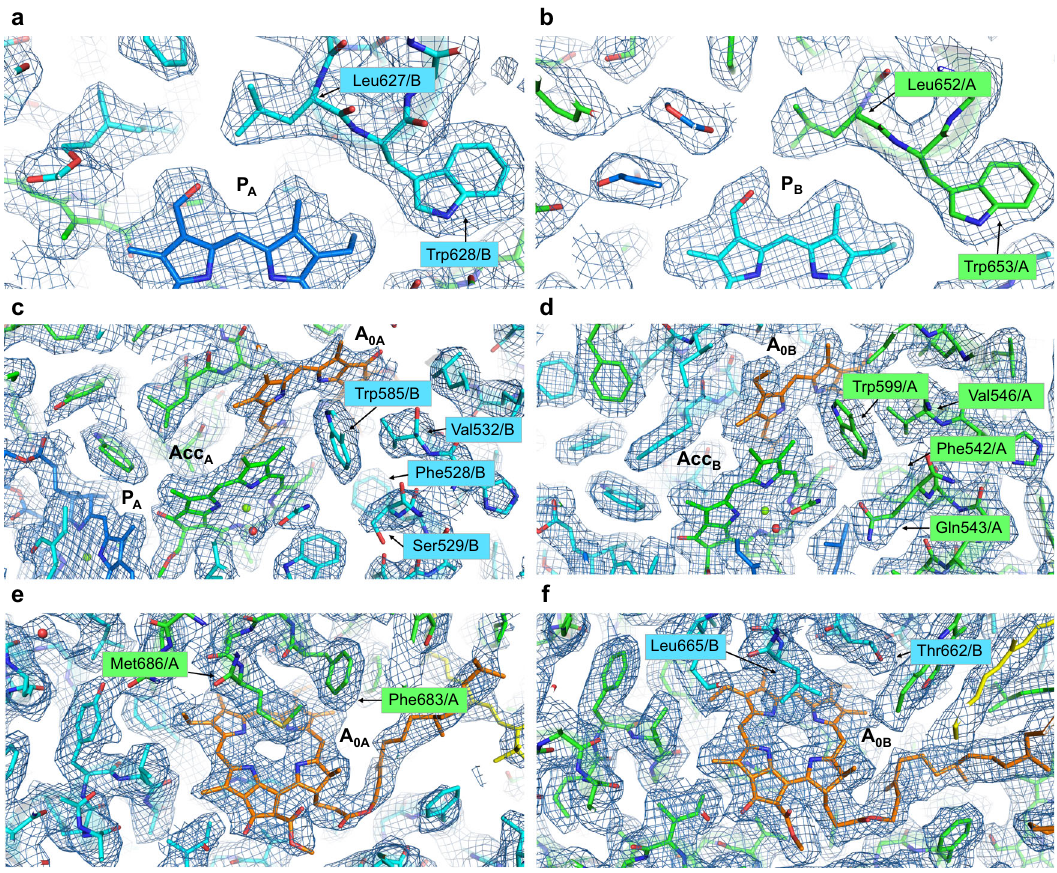
Fig. 4 Cryo-EM density maps around P740, Acc and A 0 . Each map around P740 ( a , b ), Acc ( c , d ), and A 0 ( e , f ) is shown in a mesh representation at 3.0 sigma contour level for a , b , e , and f , and 5.0 sigma for c and d for ease of recognition of the water molecule coordinating the Mg 2 + of chlorin. Colors are the same as in Fig.